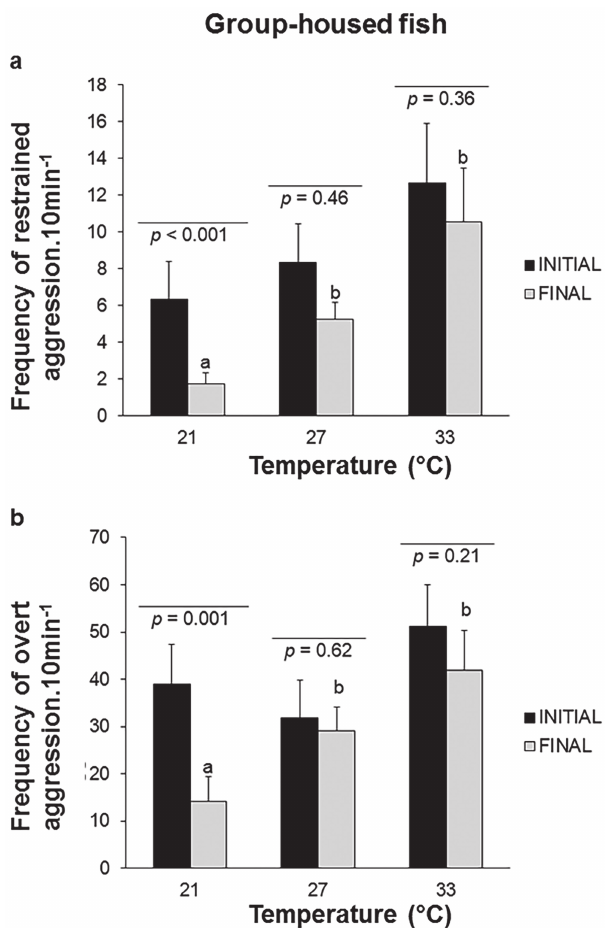
Fig. 3. Mean ± SE of initial (third day) and final (eighth day) frequencies of a. restrained aggression and b. overt aggression of group-housed fish. Different letters show differences among treatments. Mixed Model ANOVA completed by Fisher-LSD post hoc